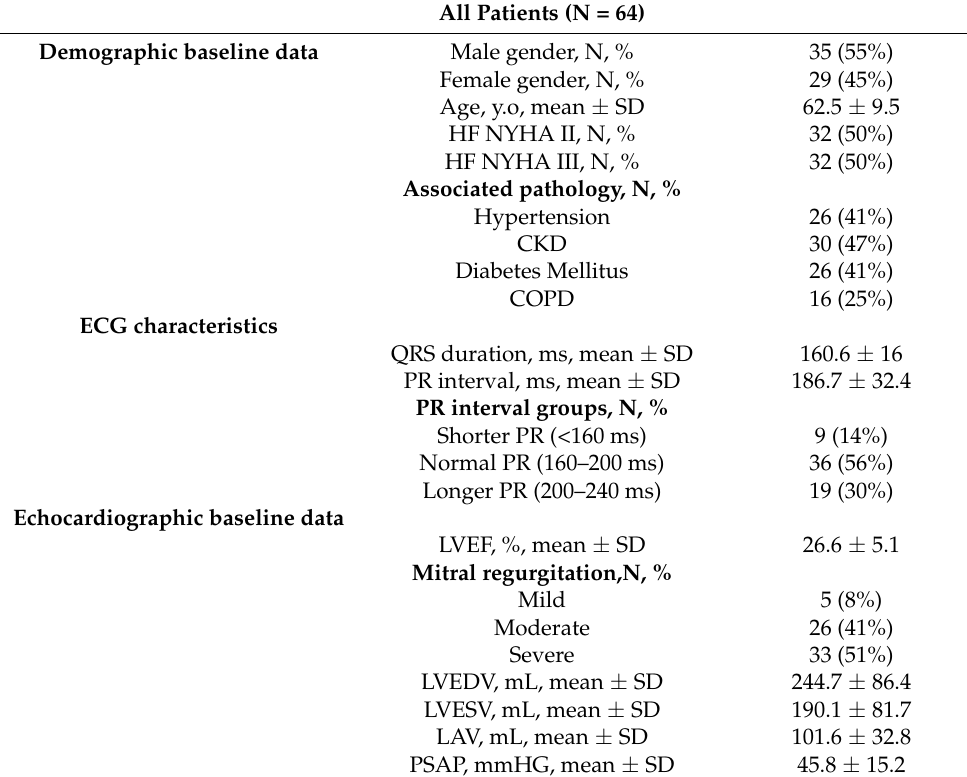
Demographic, ECG, and echocardiographic baseline data—at the moment of pacemaker